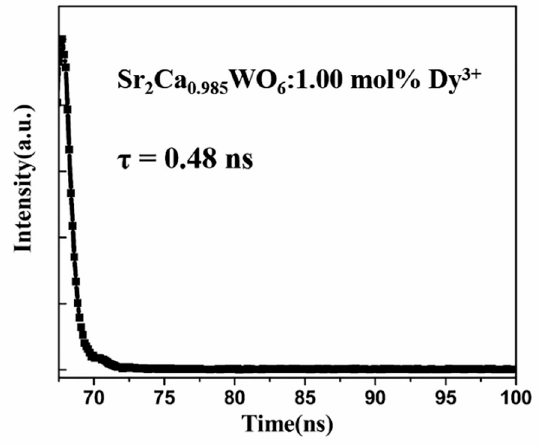
Figure 8. Decay curve of Sr 2 CaWO 6 : 1.00 mol% Dy 3+ at room temperature with λ ex = 310 nm and λ em = 499 nm.